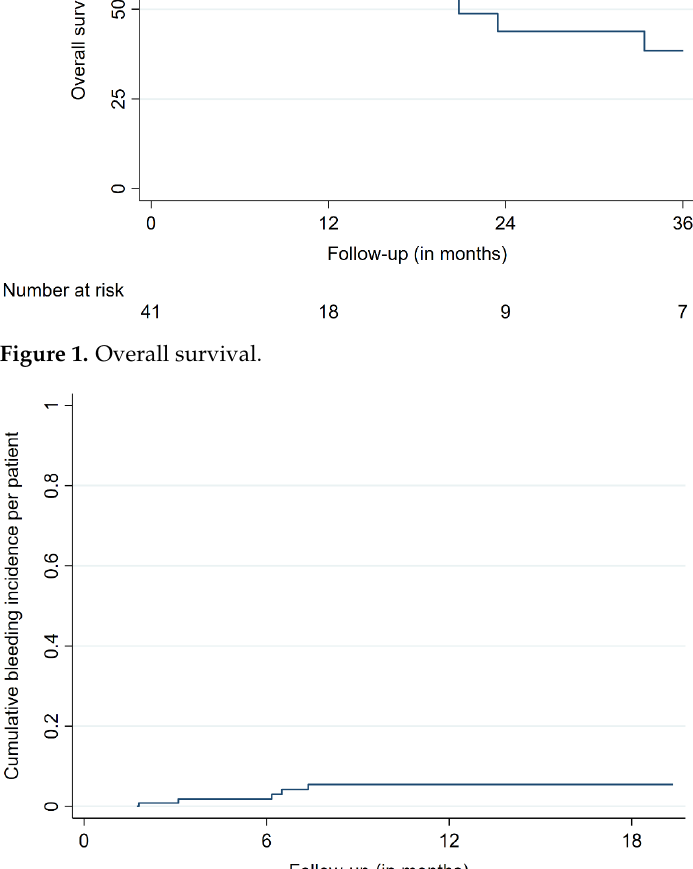
Figure 2. Cumulative incidence of bleeding events per patient.